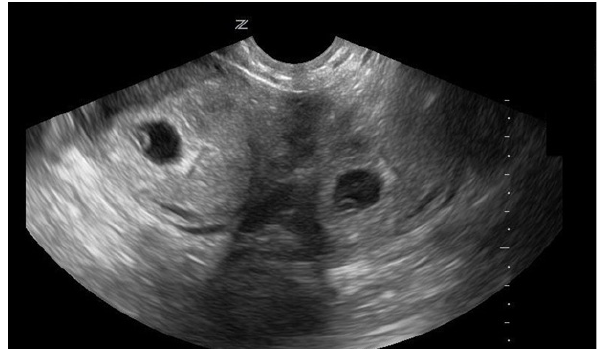
Figure 2. Longitudinal transvaginal ultrasound image yielding intrauterine pregnancy on the left and mirror-image artifact on the